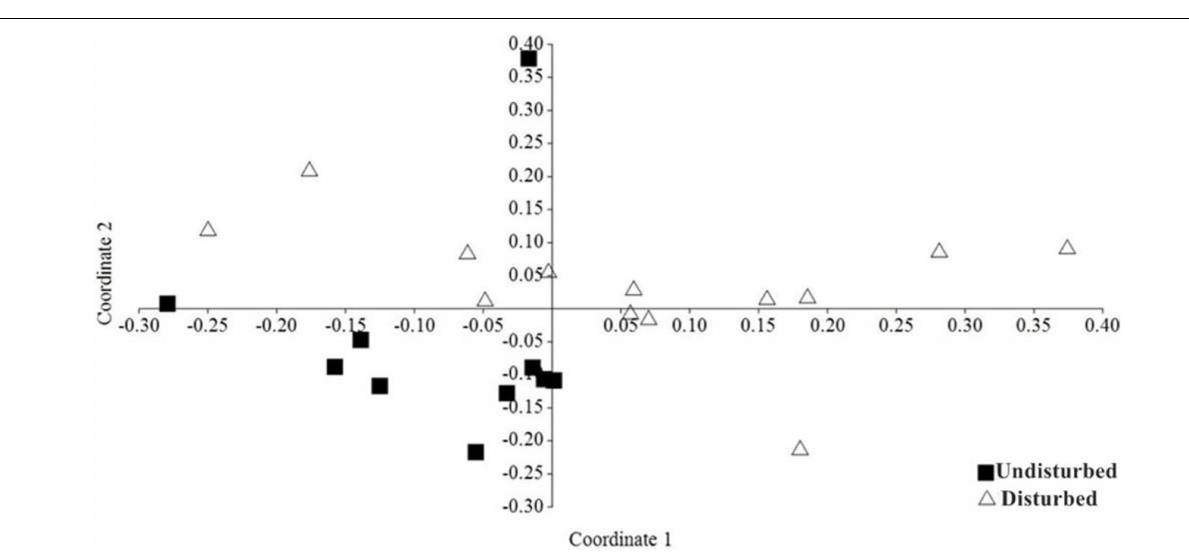
volcanic vents that probably provided day roosts for obligate cave roosters (Glover and Altringham,